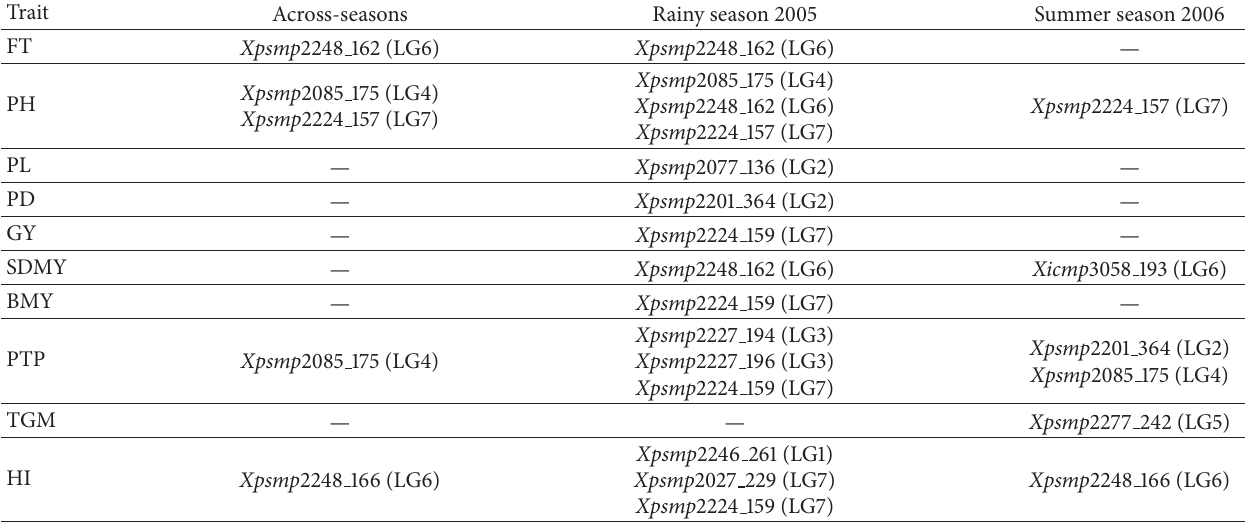
Table 5: Lists of SSR marker alleles significantly associated with phenotypic traits using the 𝑄 + 𝐾 model and the individual season BLUPs.